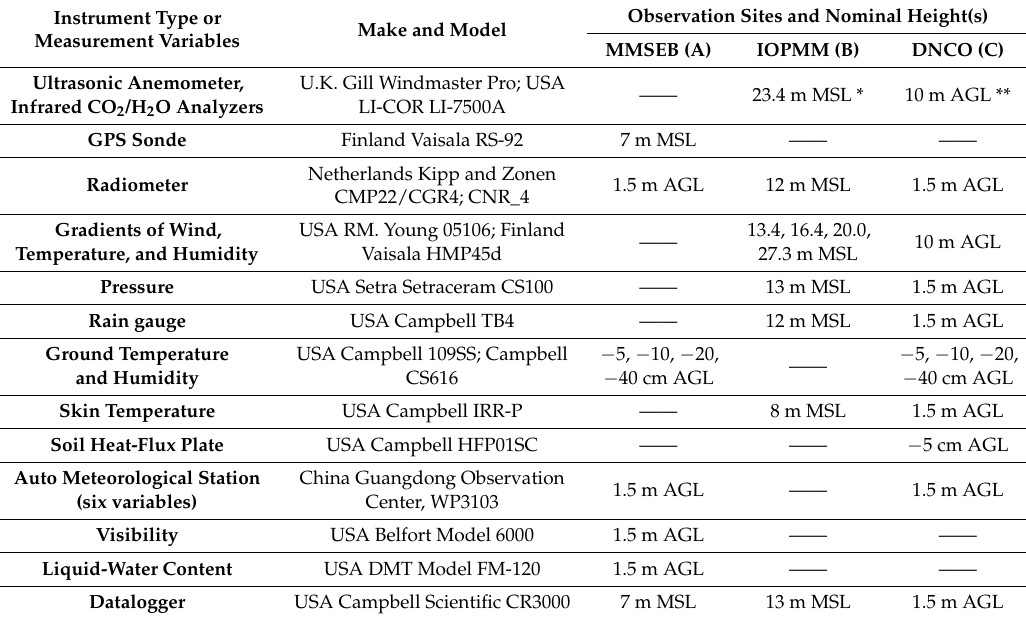
Table 1. The observation sites, instruments, and data.